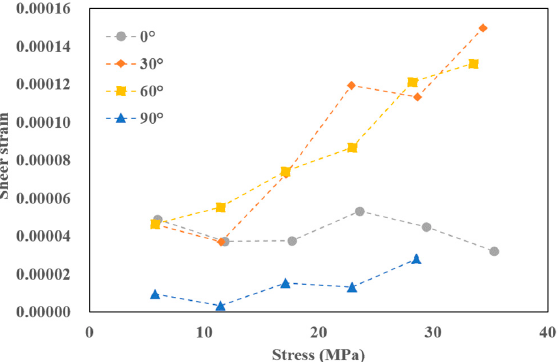
Figure 12. Scatter plot of the stress-shear strain of shale specimens with different bedding angles.